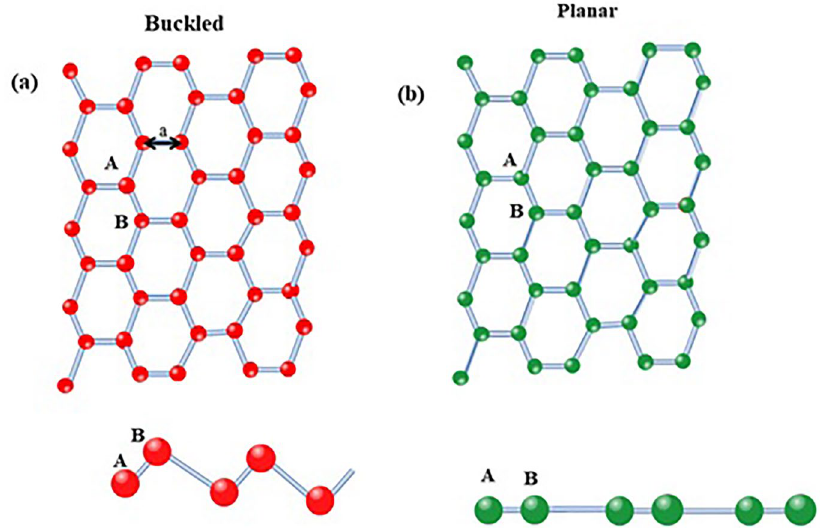
Figure 1. A schematic of the planar and buckled silicene monolayer.